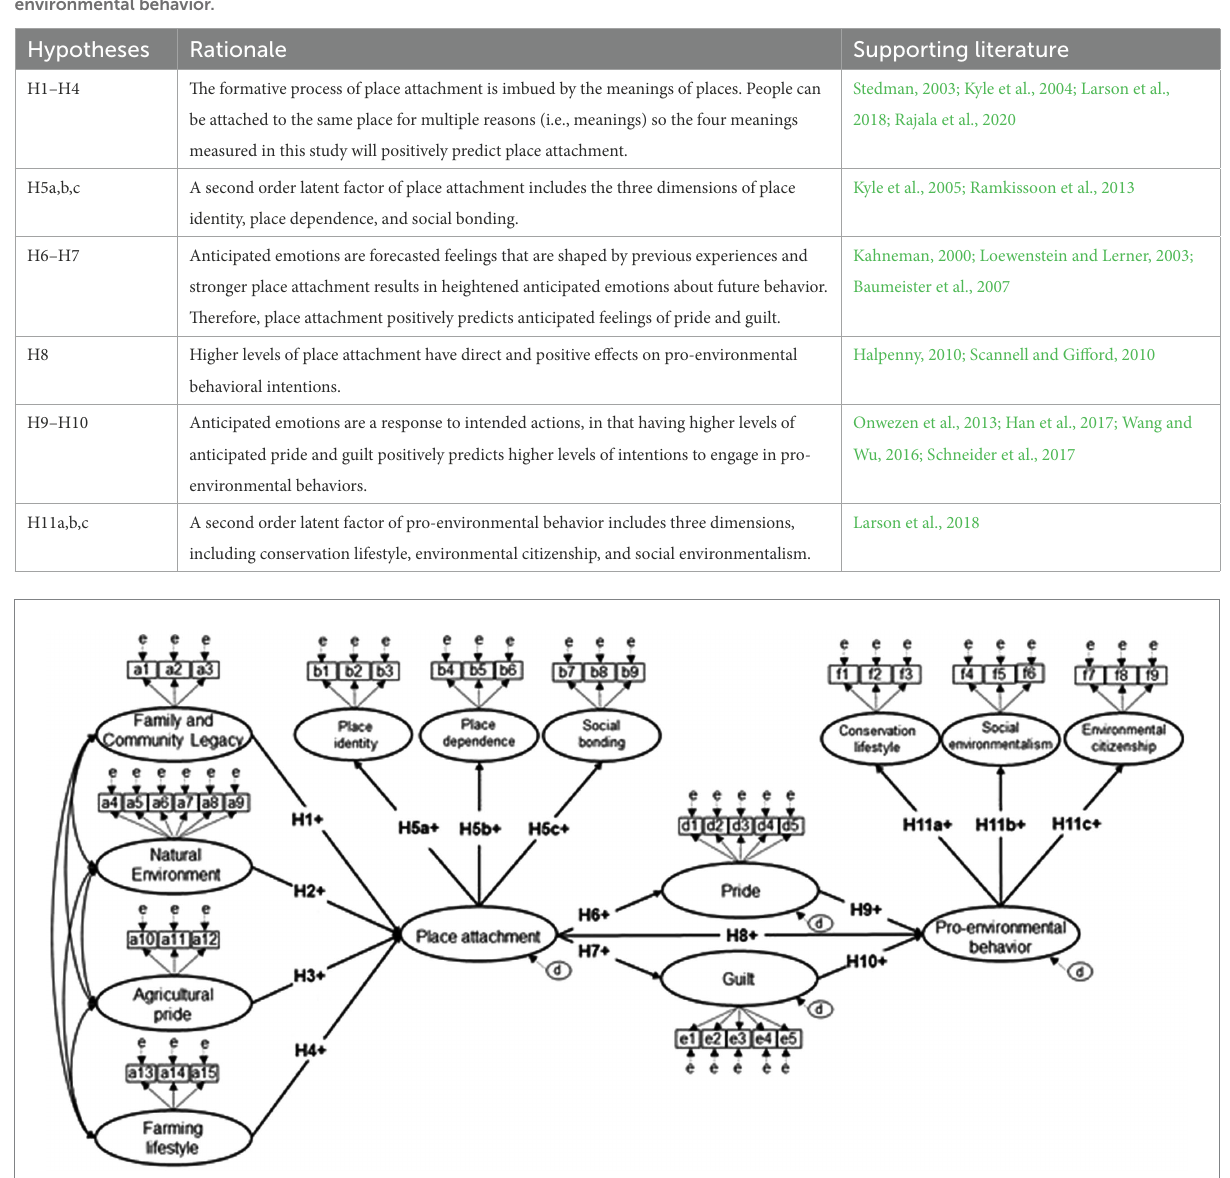
TABLE 1 Previous research supporting hypothesized relationships among place meanings, place attachment, anticipated emotions, and pro- environmental